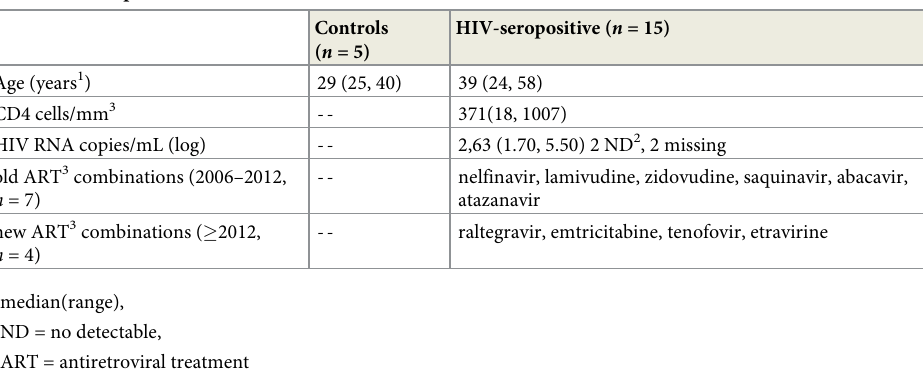
PLOS ONE | https://doi.org/10.1371/journal.pone.0231679 June 19,